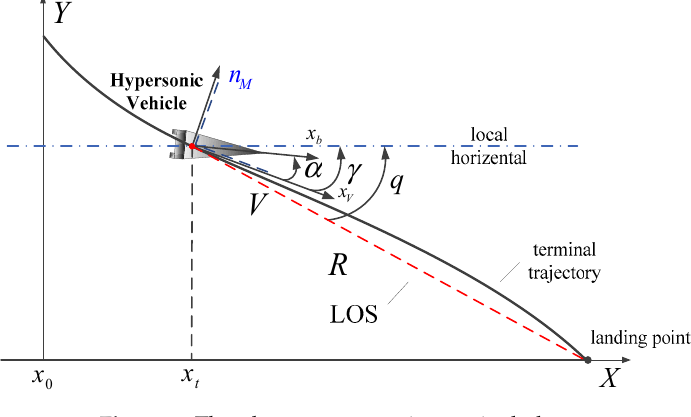
Figure 1. The planar geometry in terminal phase.